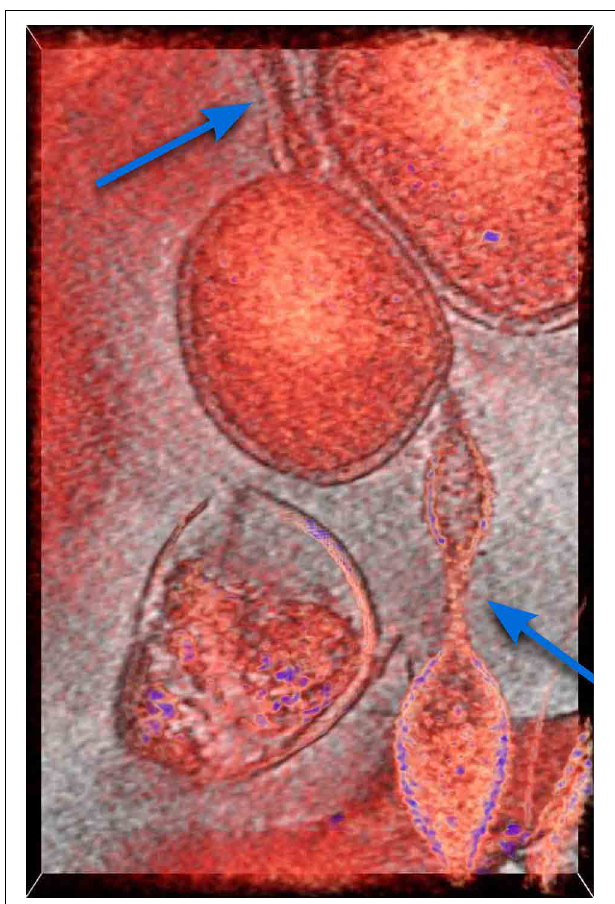
FIGURE 1 | Cryogenic-electron microscopy image of a small region of a biofilm. In red, a 50-voxel-thick slice through a tomographic reconstruction overlaid onto a one-voxel-thick slice in gray scale. There is a round cell at the center and what appears to be an extension from a different cell type into it from the bottom, and another at the top. Previous work (see Baker et al., 2010 and references therein) established they belong to different species of archaea. Arrows indicate tubular extensions or appendages connecting the microbial cell in the center to microbial cells of different species. This is established by their typical, clearly different cell walls. For more information see Comolli and Banfield (2014) in this Special Topic.